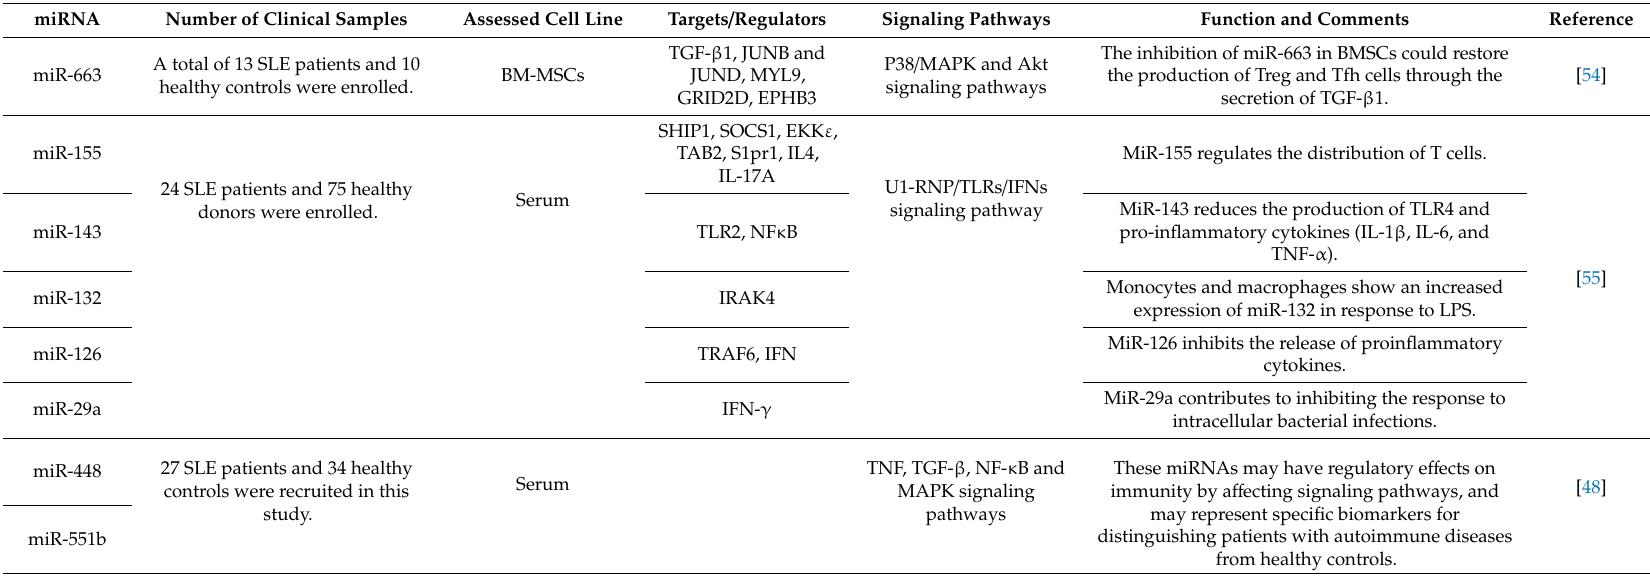
Table 5. List of miRNAs whose expression has been upregulated in SLE patients (LPS: lipopolysaccharide, DC: dendritic cell, NK: natural killer). miRNA Number of Clinical